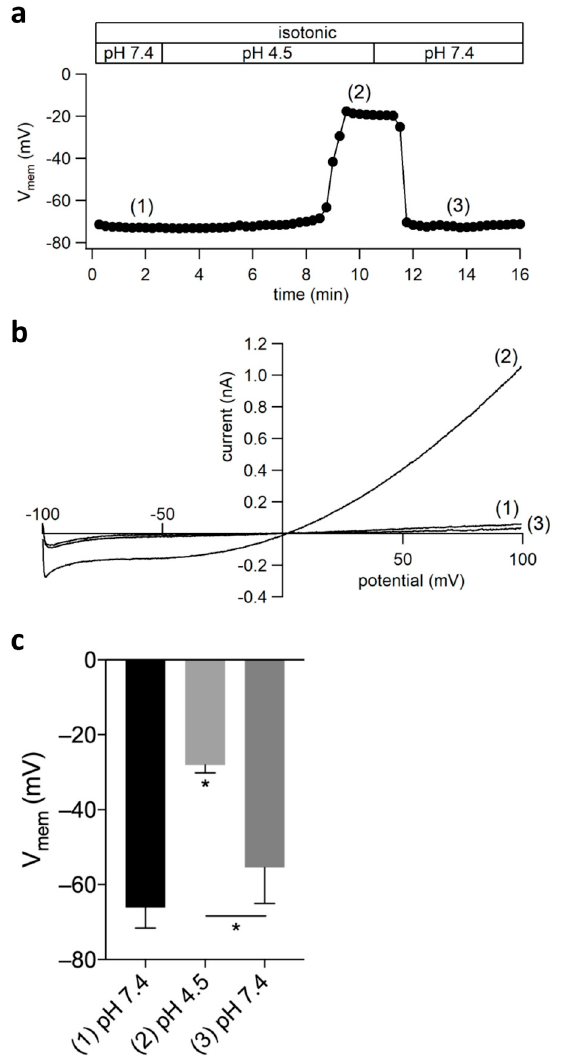
Figure 7. ASOR current activation depolarizes the cell membrane potential (V mem ): ( a ) V mem recording of a single BV-2 cell at pH 7.4, 4.5, and 7.4 again; ( b ) Whole-cell currents elicited by voltage ramps from − 100 to +100 mV before (1), during (2), and after (3) acidity-induced depolarization; ( c ) Mean V mem ± SEM of eight independent experiments as shown in a (* p < 0.05).